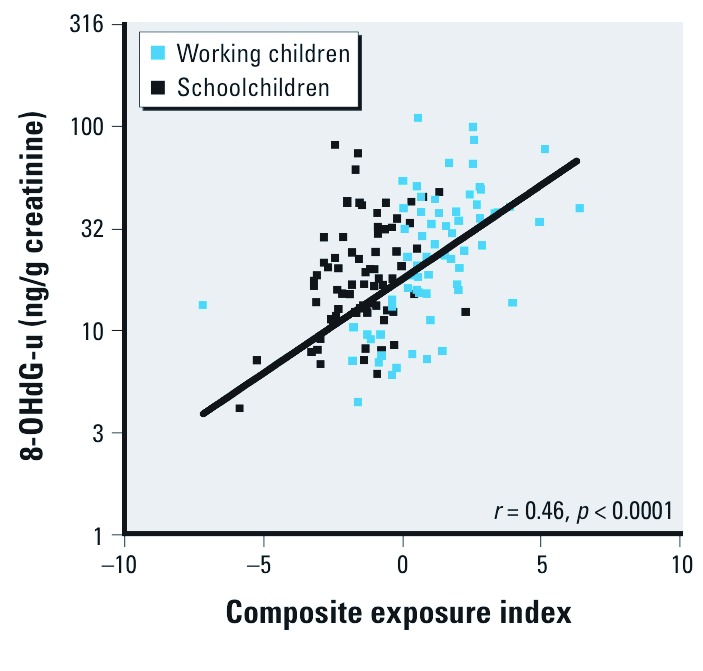
Association of 8-OHdG in urine (-u) with a composite metal exposure index. The y-axis is logarithmically scaled. The data points are individual values.